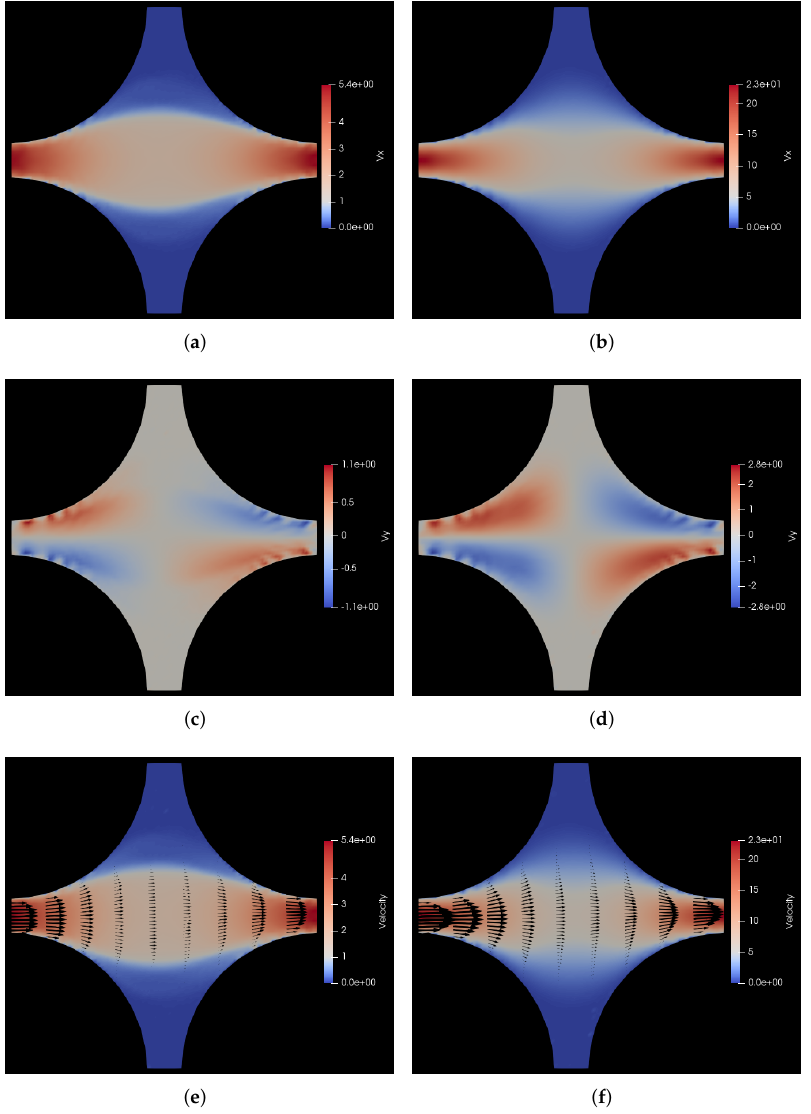
Figure 3. Comparison of velocity profiles for flow of polymer solution with the flow of solvent through a cylindrical porous medium with pressure applied in the positive x direction. ( a ) v x for flow of polymer solution. Here, v x varies from 0 to 5.4 σ /s, i.e., 0 to 27 µ m/s; ( b ) v x for flow of solvent. Here, v x varies from 0 to 23 σ /s, i.e., 0 to 115 µ m/s; ( c ) v y for flow of polymer solution. Here, v y varies from − 1.1 to 1.1 σ /s, i.e., − 5.5 to 5.5 µ m/s; ( d ) v y for flow of solvent. Here, v y varies from − 2.8 to 2.8 σ /s, i.e., − 14 to 14 µ m/s; ( e ) v for flow of polymer solution. Here, v varies from 0 to 5.4 σ /s, i.e., 0 to 27 µ m/s; ( f ) v for flow of solvent. Here, v varies from 0 to 23 σ /s, i.e., 0 to 115 µ